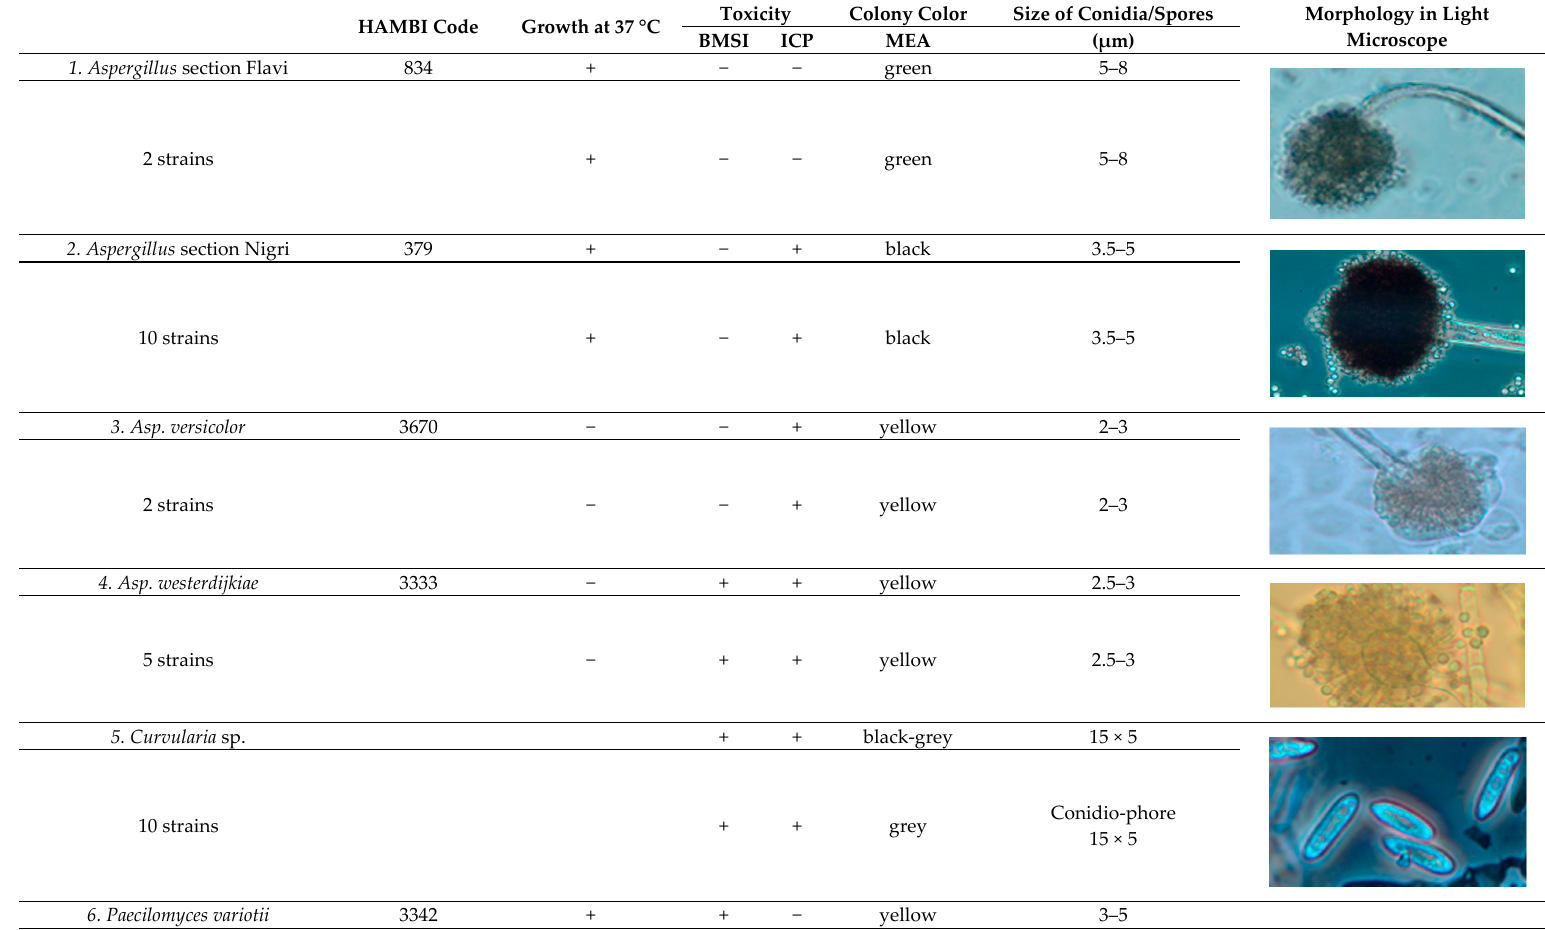
Table 7. The twelve morphotypes representing the dominant fungal genera and species isolated from the extract filter, settled dust and outdoor air.